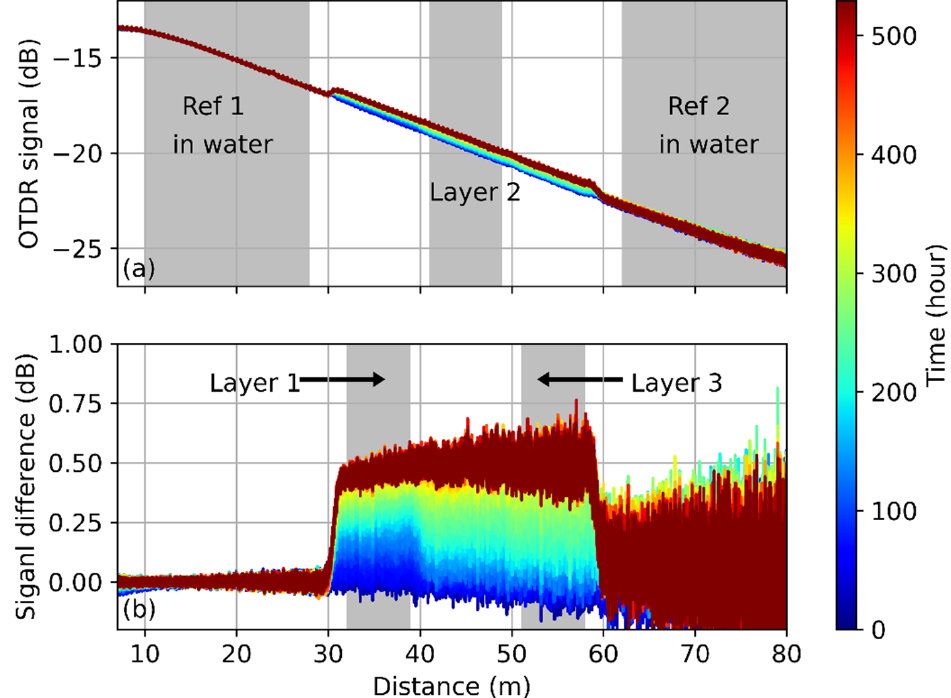
Figure 2. OTDR measurement at 650 nm during the concrete drying process. ( a ) Obtained OTDR traces and ( b ) OTDR signal changes compared with the first trace. Trace color denotes the measured time.